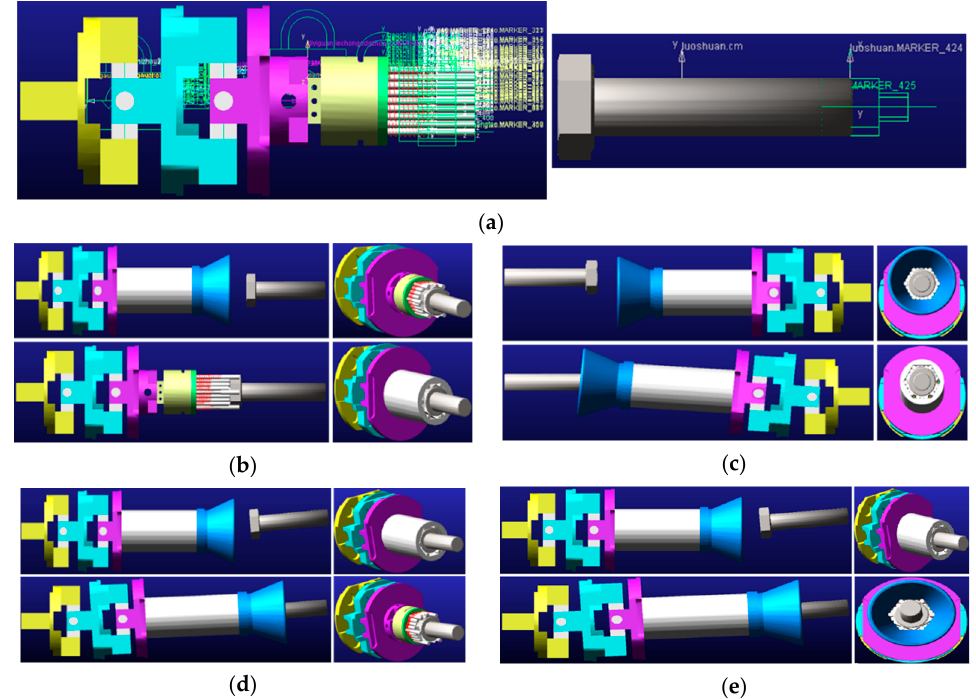
Figure 21. Function simulation analysis of end effector. ( a ) Add motion pair and force. (b ) Docking